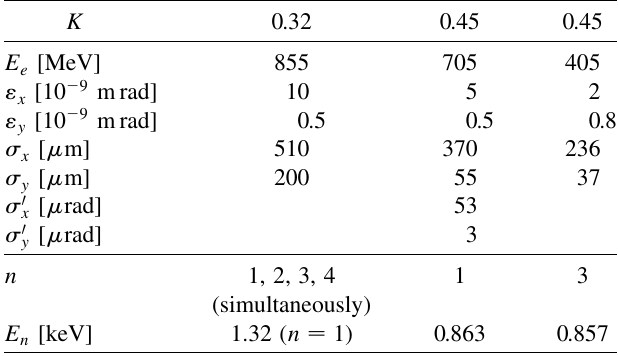
TABLE I. Undulator, electron beam (energy, unnormalized typical emittances, measured beam radii, and divergences at the position of the undulator), and radiation parameters for the two independent performance tests of the undulator at the Mainz microtron as described in the text.